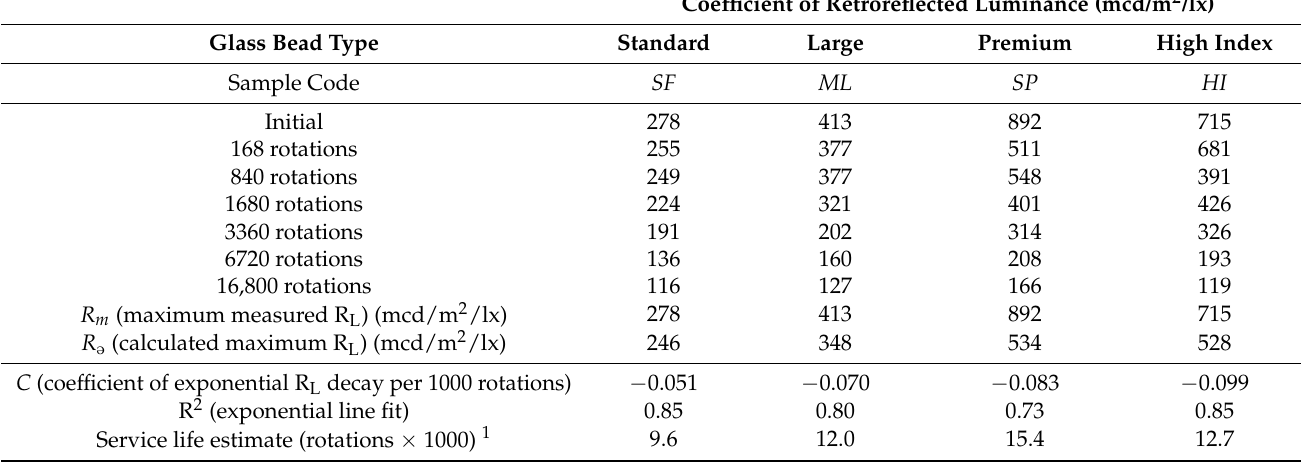
Table 4. Abrasion test: loss of R L and service life parameters calculated per Equation